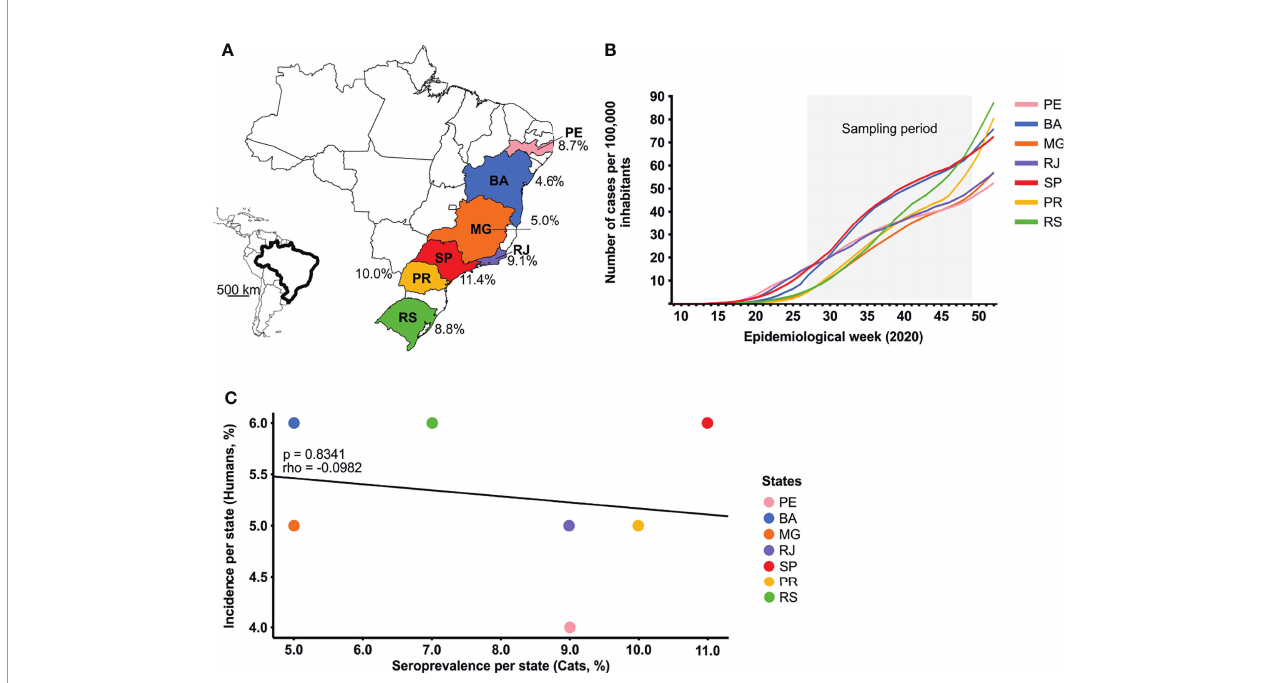
FIGURE 2 | Sampling sites and COVID-19 incidence. (A) SARS-CoV-2 seroprevalence in cats in different states in Brazil. (B) Weekly SARS-CoV-2 incidence per 100,000 habitants among different states in Brazil. (C) Spearman ’ s rank correlation comparing SARS-CoV-2 seroprevalence in cats and cumulative cases in